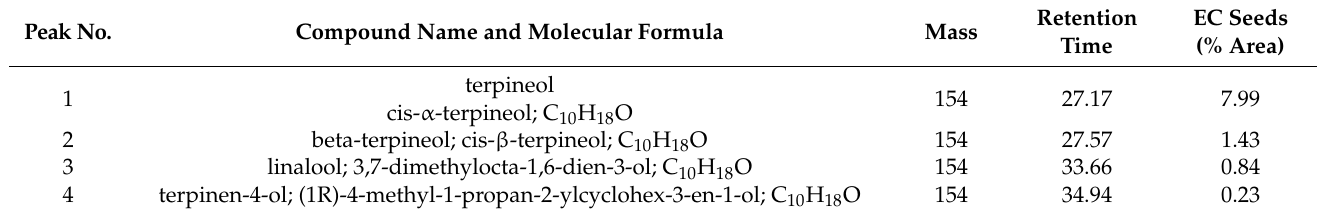
Table 2. Identification of compounds present in cardamom seeds by GC-MS analysis (peaks from Figure